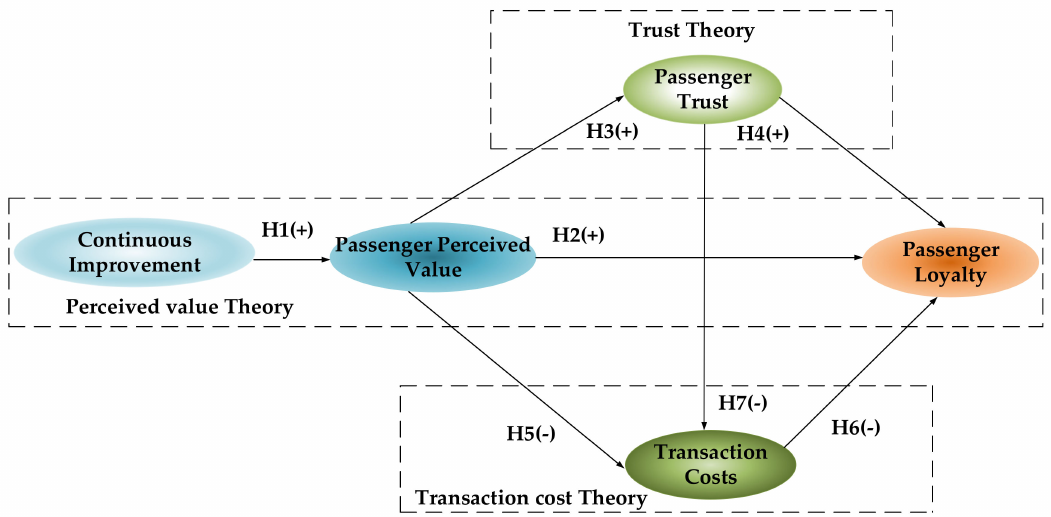
Figure 2. Theoretical model. Notes: ( + ) represents positive influence, (-) represents negative